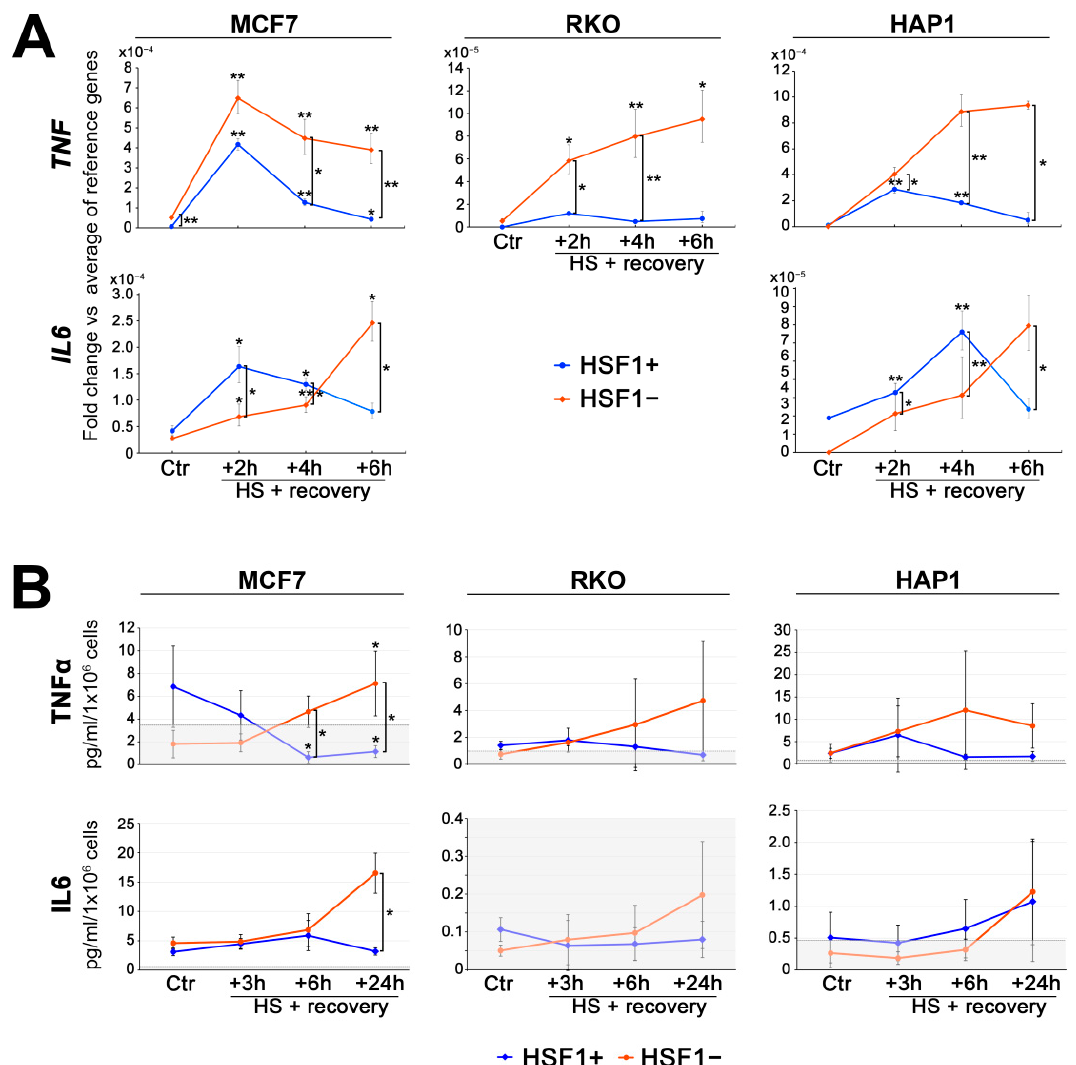
Figure 4. The production of inflammatory cytokines in HSF1+ and HSF1 − MCF7, HAP1, and RKO cells. ( A ) Transcriptional changes of TNF and IL6 in response to heat shock. Expression was analyzed by RT-qPCR in cells exposed to elevated temperature (HS: 43 °C/1 h + recovery 37 °C/2 h, 4 h, or 6 h), and fold changes were calculated versus the average of reference genes (due to the undetectable transcript level in some untreated control, Ctr, samples). IL6 was not detected in RKO cells. ( B ) The level of TNF α and IL6 released by cells exposed to elevated temperature (HS: 43 °C/1 h + recovery 37 °C/3 h, 6 h, or 24 h) was analyzed by ELISA. Values in the gray box are below the assay quantitation range. The difference between treated and untreated cells, as well as between HSF1+ and HSF1 − in each time point: ** p < 0.001, * p < 0.05.